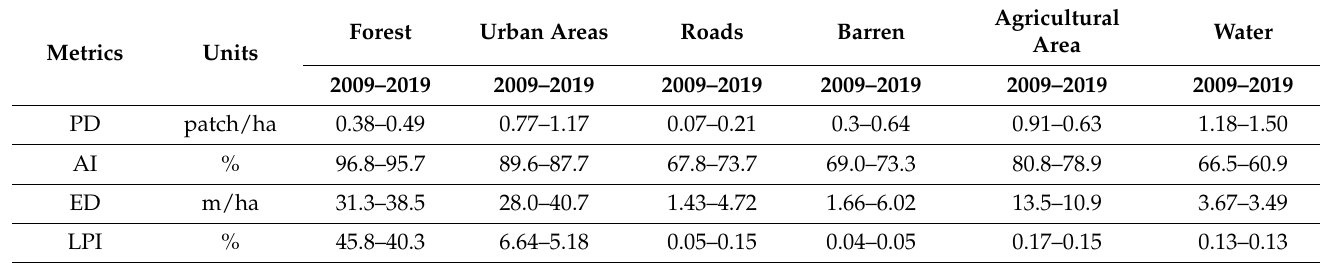
Table 6. Results of landscape